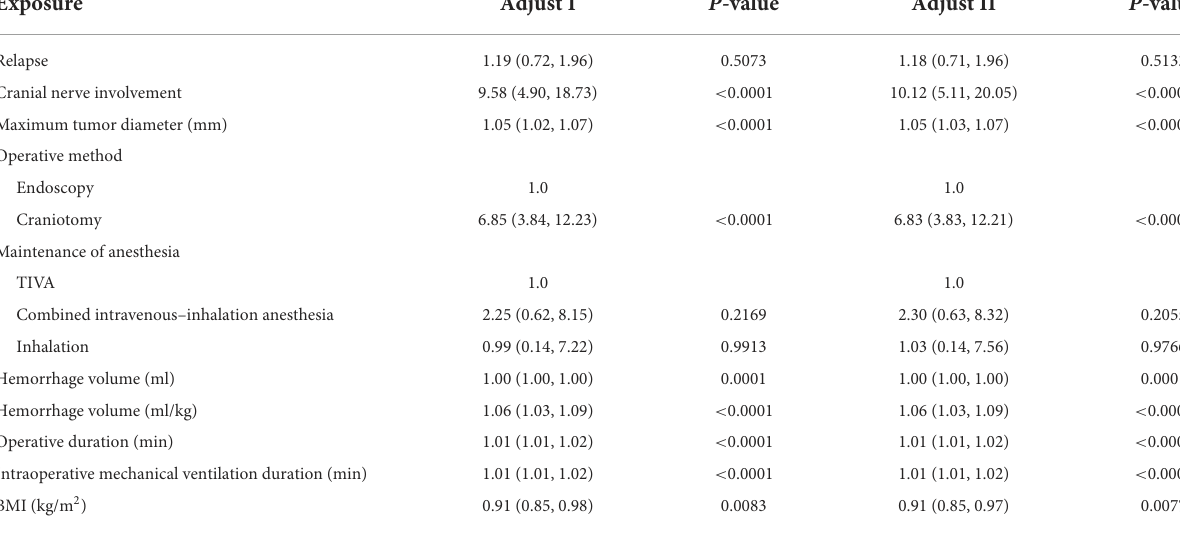
TABLE 4 Multifactorial regression for risk factors associated with retained artificial